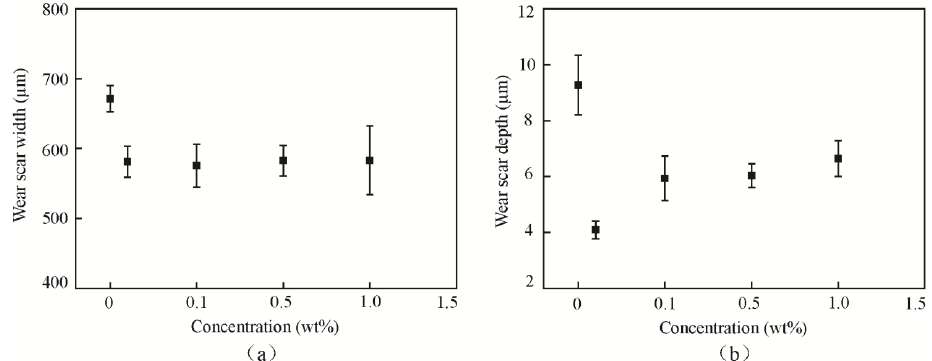
Figure 4. Wear scar ( a ) width and ( b ) depth of surfaces lubricated by base oil with different concentrations of micro-lamellar MoO 3 additives.